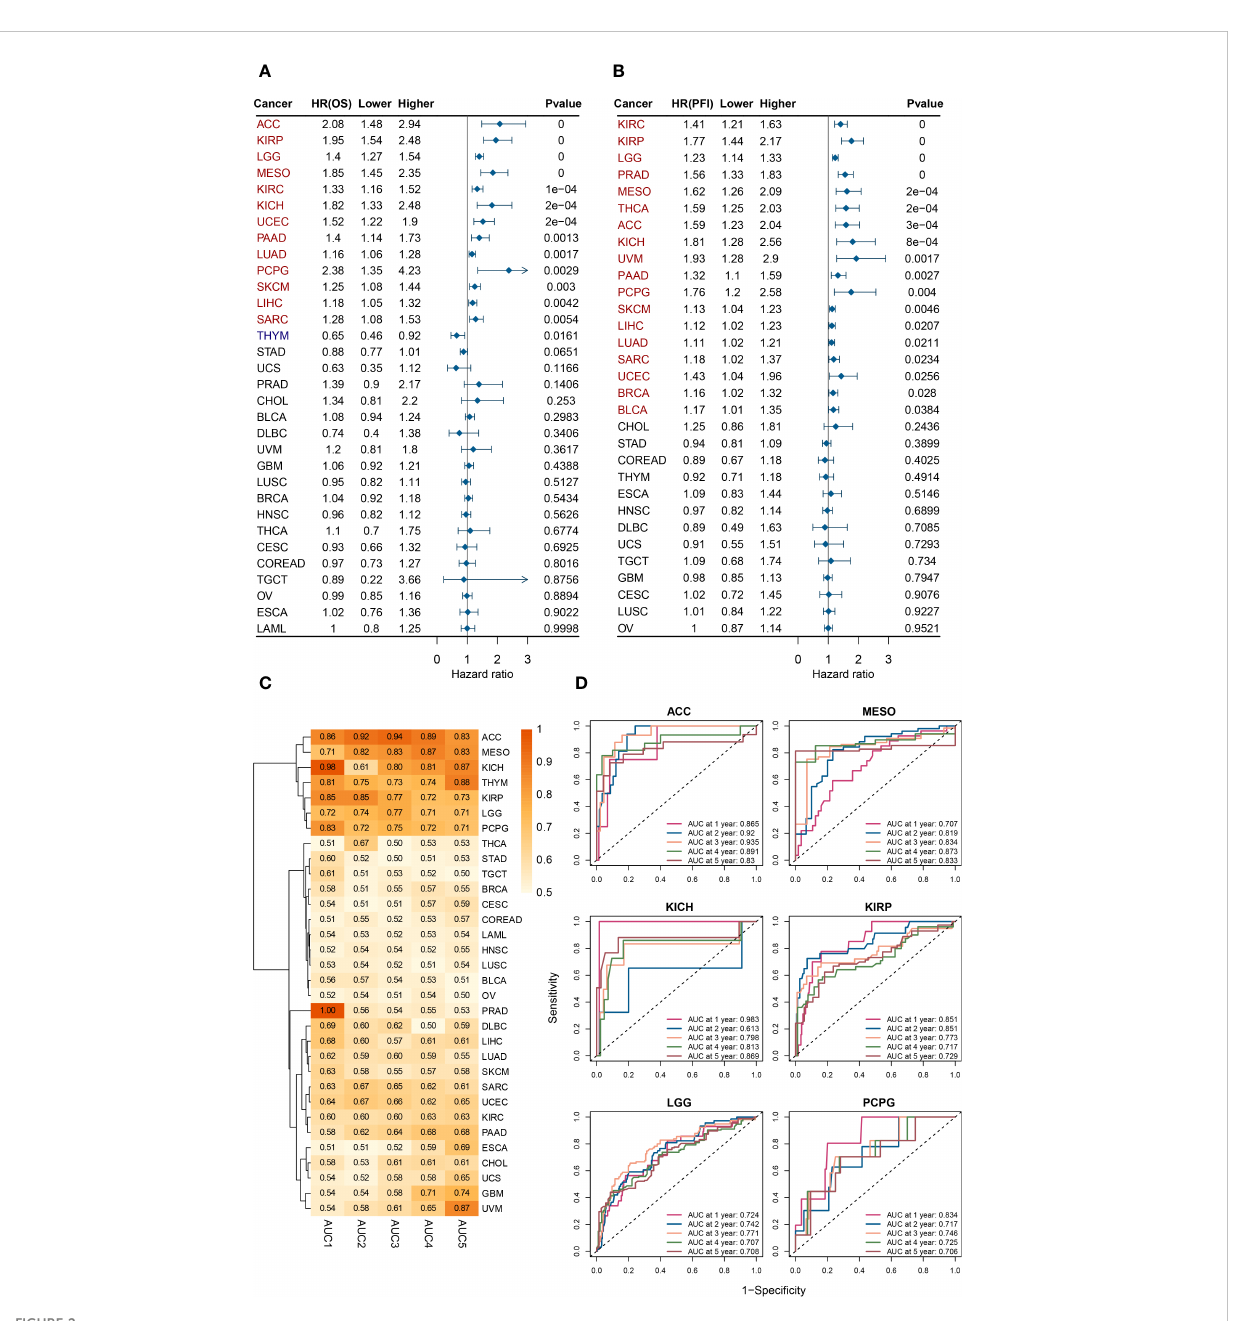
(Figure 2D). Speci fi cally, in ACC, the AUC of ESPL1 predicted prognosis with a value between 0.83 and 0.94. In GBM and UVM, the AUC for predicting 5-year survival reached 0.74 and 0.87, was poor.